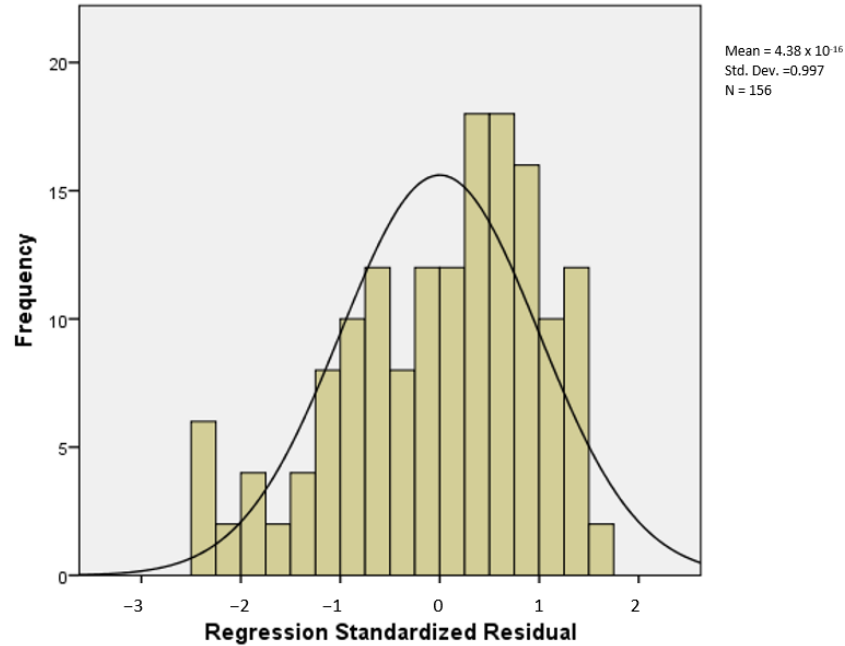
Figure A2. Histogram using physical health as the dependent variable.